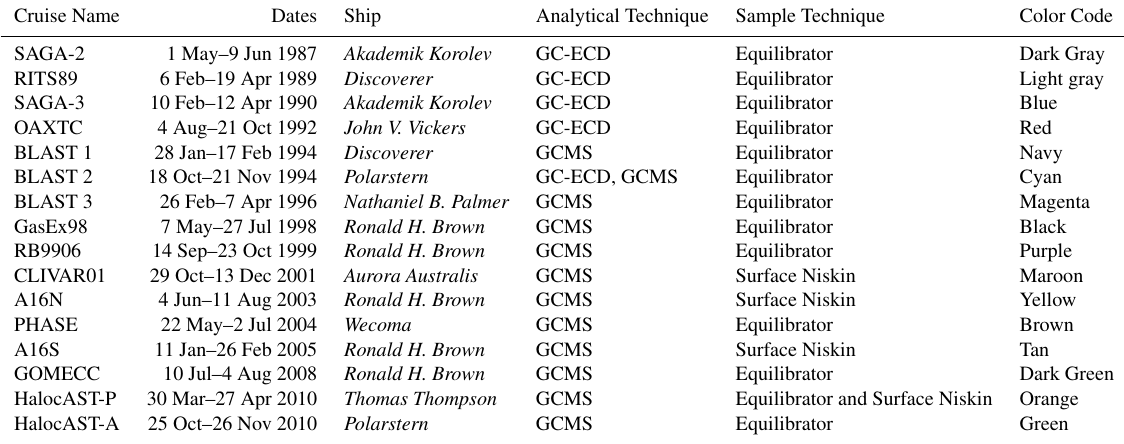
Table 1. Cruise details including season, ship, analytical technique used to measure CCl 4 , water sampling technique, and color code for Figs. 1 and 5. Gas chromatography with electron capture detection (GC-ECD) and gas chromatography with mass spectrometry (GCMS) are the analytical techniques.